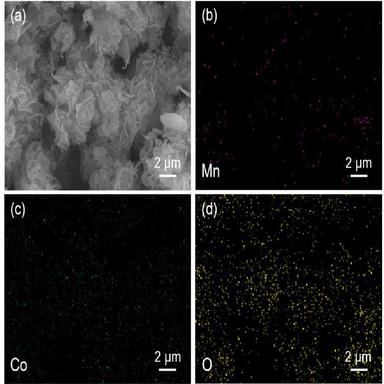
(a) SEM image of MnCo2O4.5 nanosheets and the related elemental mappings of (b) Mn, (c) Co, and (d) O, respectively.